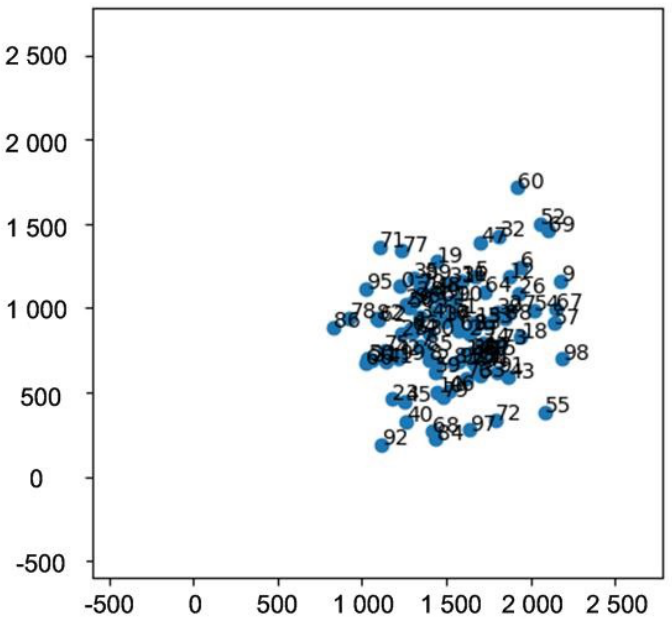
Figure 12. A sensor network with 100 randomly deployed nodes. The dots with the numbers beside them are nodes and their IDs. The nodes can be deployed randomly with the only requirement that they can form a connected graph. The distribution is generated by randomly picking a node already deployed and placing a new node randomly within its communication range, repeating this process until the number of nodes deployed reaches the target